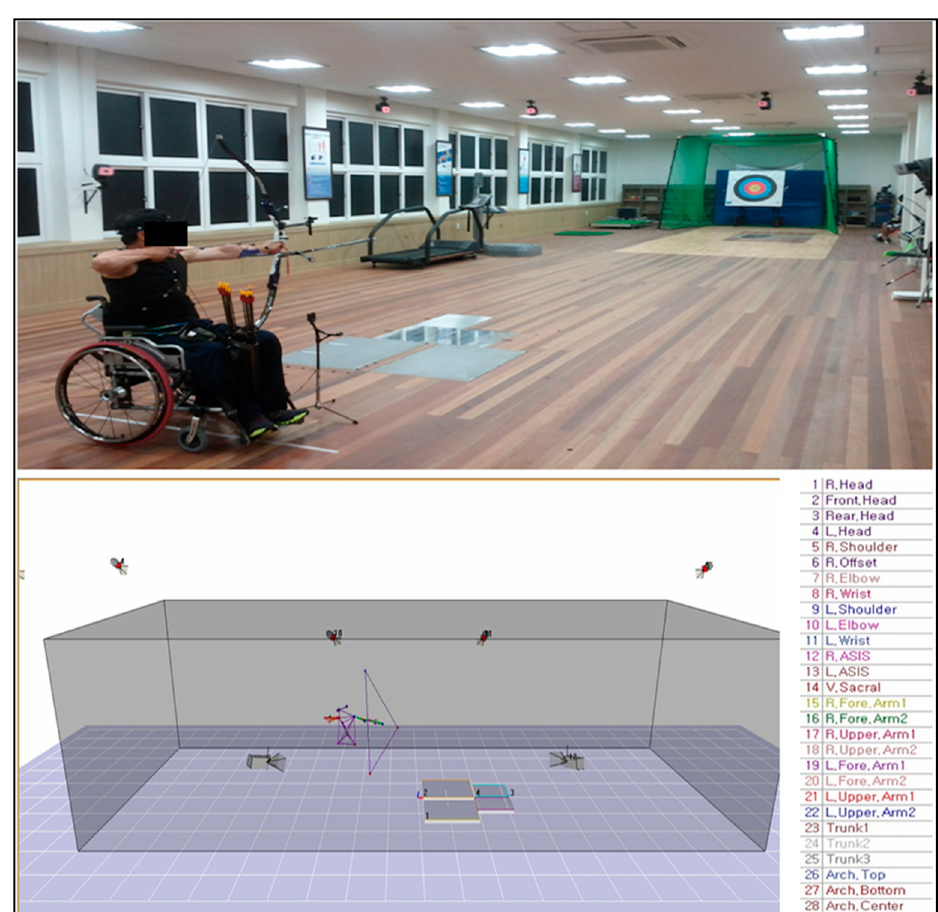
Figure 1. Experimental layout.